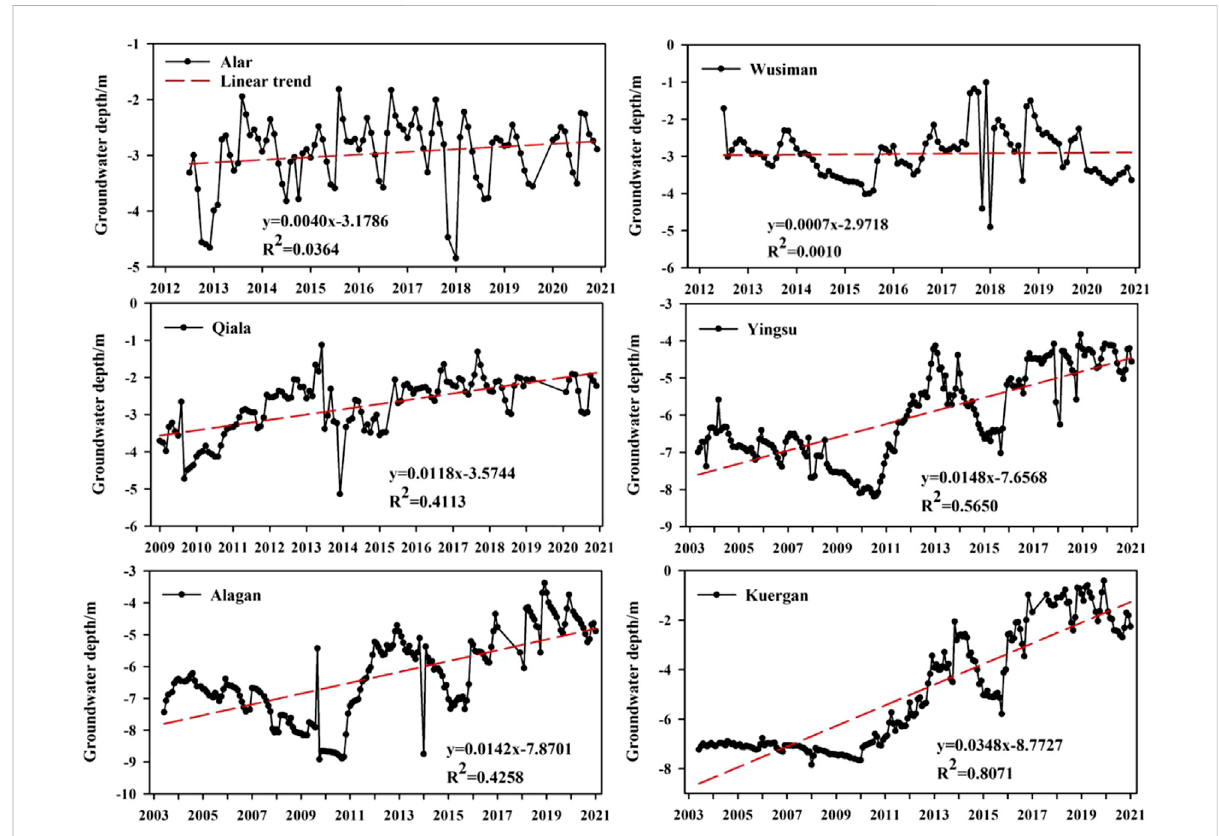
FIGURE 3 The variation process of groundwater depth in each section of the main stream of Tarim River month by